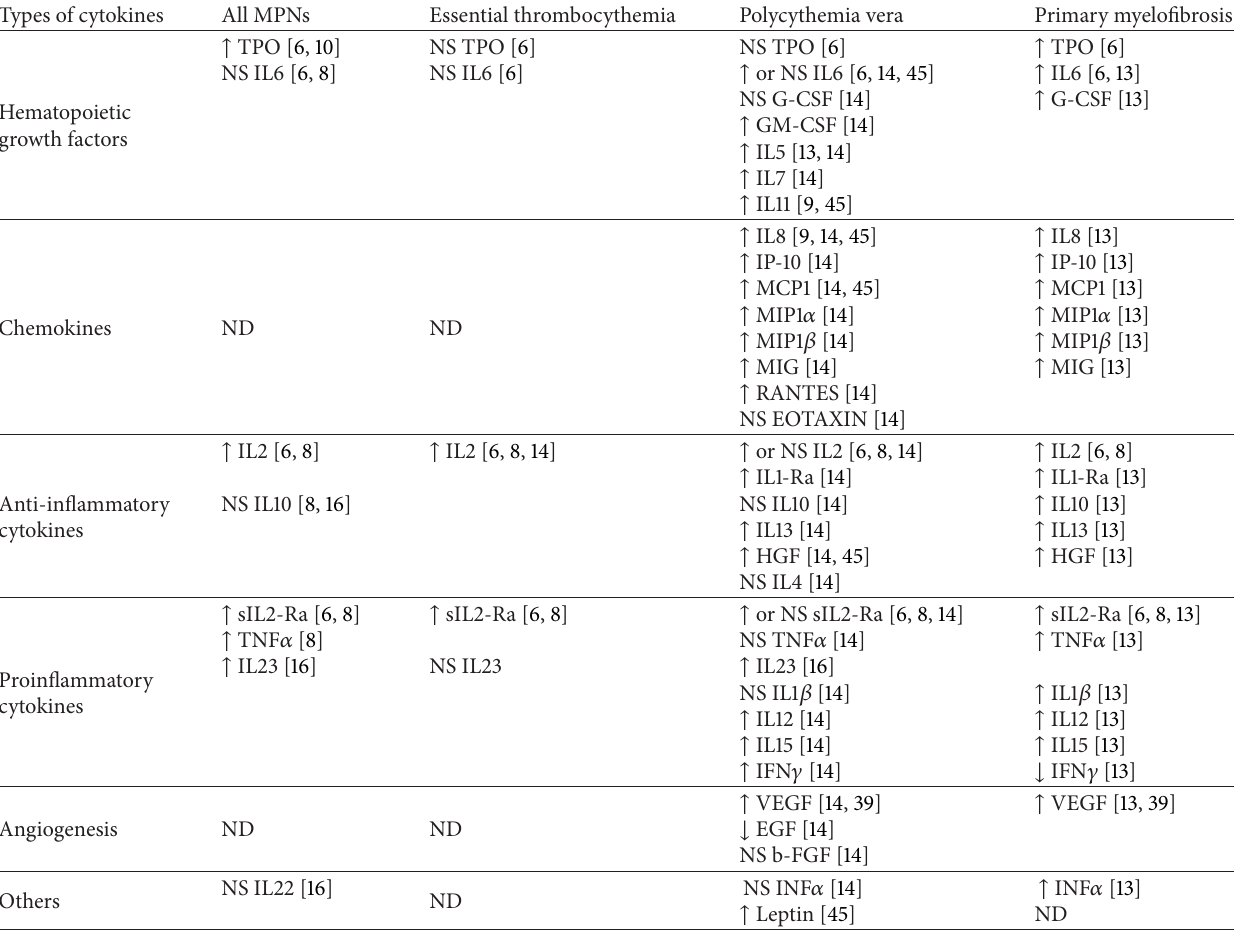
Table 1: Circulating cytokine expression in myeloproliferative neoplasms compared to healthy controls. Types of cytokines